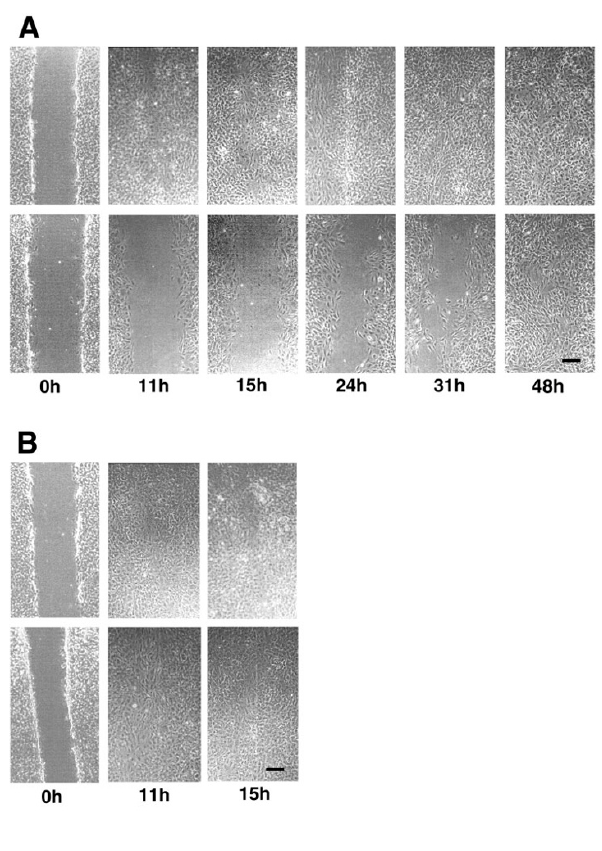
Figure 3 Phase-contrast photomicrographs showing the process of wound repair by wild-type (upper panel) and SPARC-null (lower panel) fibroblasts cultured in the absence of SPARC (A) and in the presence of SPARC (B). In (A), wild-type (upper panel) and SPARC-null (lower panel) fibroblasts were grown to confluence in DMEM containing 10% FBS and then wounded (example shown at 0 hour). Wound closure was monitored at various time points. Wound healing is delayed in SPARC deficient fibroblasts. In (B), wounded monolayers of wild-type (upper panel) and SPARC-null (lower panel) fibroblasts were cultured in DMEM containing 10% FBS and SPARC protein purified from human platelets. Exogenous SPARC restores wound healing ability of SPARC-null cells to the level of wild-type cells. Scale bar, 62.5 µ